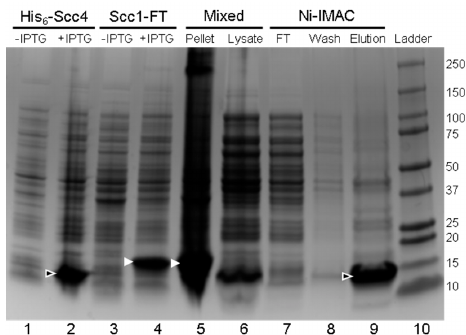
Figure A1. SDS-PAGE analysis of cell-cell mixture. Lanes are numbered at the bottom. Lanes 1 and 2 and lanes 3 and 4 are proteins in the cultures before (-IPTG) and after (+IPTG) induction of His 6 -Scc4 and Scc1-FLAG, respectively. Lanes 5 and 6 are the pellet and clarified lysate produced after the cells were mixed and lysed together. Lanes 7, 8, and 9 are the lysate that flowed through the Ni-IMAC resin (FT), buffer wash step, and imidazole elution, respectively. The arrow heads indicate bands for Scc1-FLAG (18.2 kDa) and His 6 -Scc4 (15.8 kDa). Lane 10 is the protein molecular weight marker (Bio-Rad Precision Plus protein ladder) with molecular weights listed to the right in kDa.